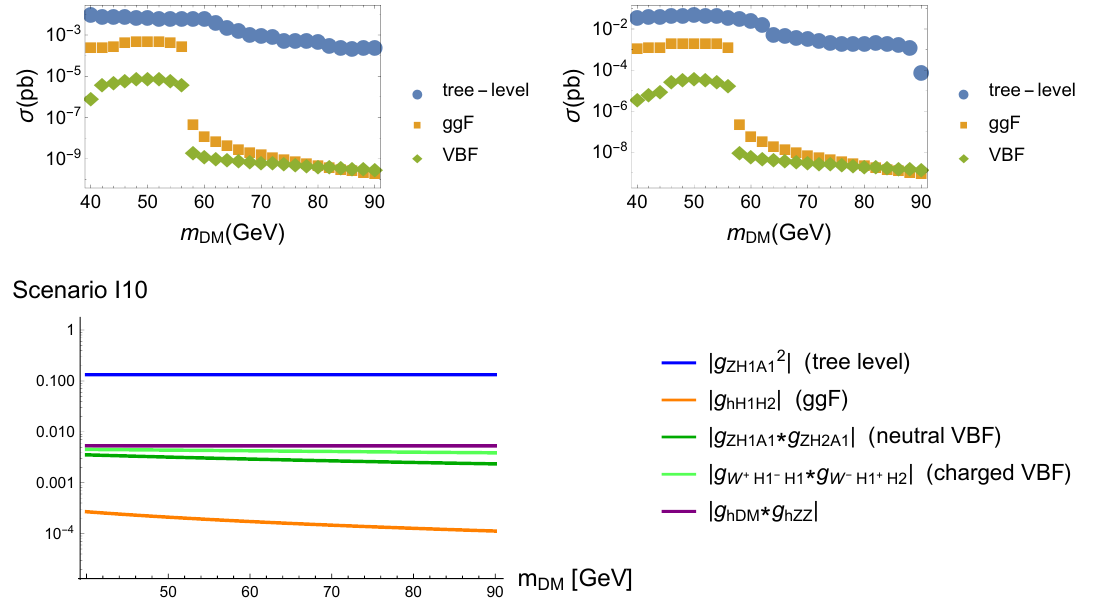
Figure 11 . The anatomy of scenario I10. The plots on the top show the cross sections of the tree- level, ggF and VBF processes with leptonic (left) and hadronic (right) (cid:12)nal states. At the bottom we show the dominant couplings in each process in Log scale with the same color coding where the Higgs-DM coupling is shown for reference. Note that the g hH cross section